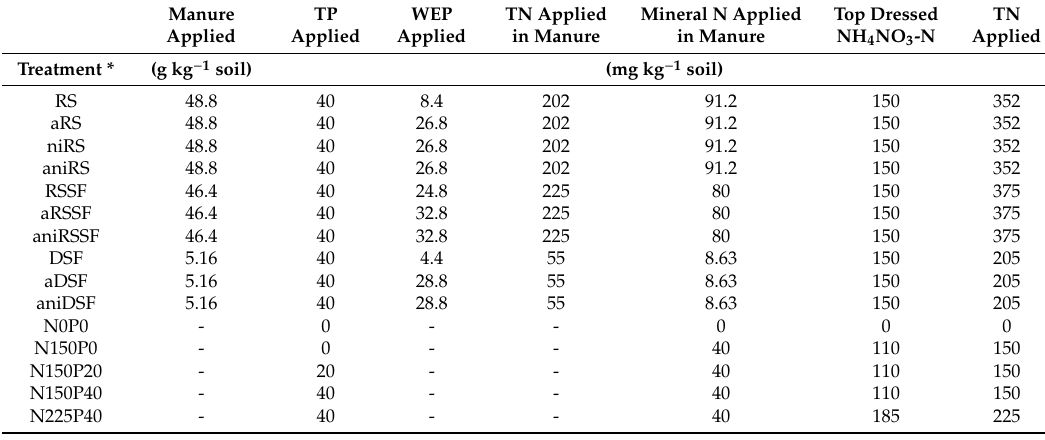
Table 2. Nutrients applied to each pot with the application of the di ff erent manures and mineral fertilizers. Organic fertilizers were applied at di ff erent weights to reach the same level of 40 mg P added kg − 1 soil (pot = 2.5 kg of dry soil). Manure TP WEP Applied Applied